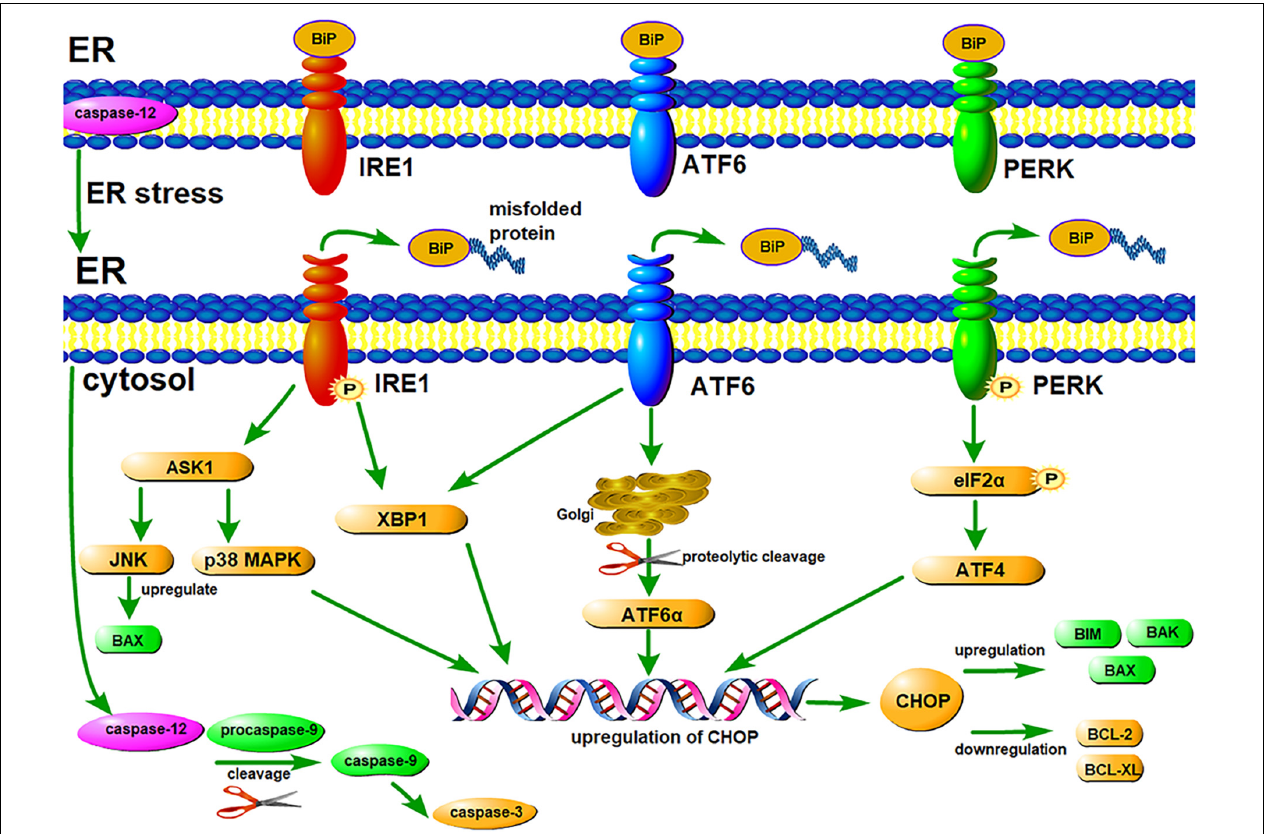
FIGURE 1 | ER stress-mediated UPR signaling pathways and apoptosis signaling pathways. Three ER transmembrane proteins, IRE1, ATF6, and PERK, are involved in UPR signaling pathways. Under normal conditions, these proteins are combined with ER chaperone BiP, and located in the ER membrane in an inactive state. Under ER stress, when a misfolded protein binds to BiP, BiP dissociates from IRE1, ATF6, and PERK. Subsequently, PERK and IRE1 undergo autophosphorylation, and ATF6 undergoes proteolytic cleavage. Downstream signaling pathways of UPR are initiated, thereby maintaining ER homeostasis. However, under chronic or excessive ER stress, UPR fails to maintain the homeostasis of ER, then apoptosis signaling pathways are activated. All the three ER transmembrane proteins can up-regulate CHOP, leading to apoptosis by regulating the expression of some BCL-2 family members. Activated IRE1 can activate JNK, inducing apoptosis by up-regulating the expression of some pro-apoptotic proteins. Caspase-12 can induce apoptosis by activating the caspase cascade